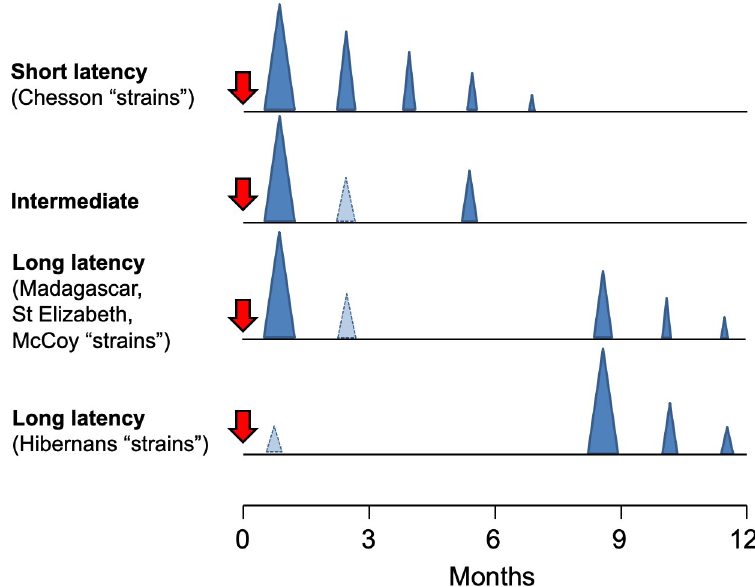
Fig 2. Plasmodium vivax relapse patterns. The temporal patterns of P . vivax relapse in different “strains.” The red arrow indicates the infective mosquito bite which leads to the primary infection. The blue triangles represent patent P . vivax infections; the largest triangle is the primary infection. The proportions of successive relapses decline, and there is an increasing probability that the relapses are oligosymptomatic or asymptomatic. The translucent blue triangles are P . vivax infections which may sometimes occur. The short latency frequent relapse pattern (typified by the “Chesson strain”) is prevalent across tropical areas. The intermediate phenotype may occur in South Asia. The long latency phenotype (typified by the Madagascar, St Elizabeth, and McCoy strains) is found in Central America, North Africa, and central Asia, while the long latency “hibernans” phenotype, which was prevalent in Northern Europe and Russia, is still found in North